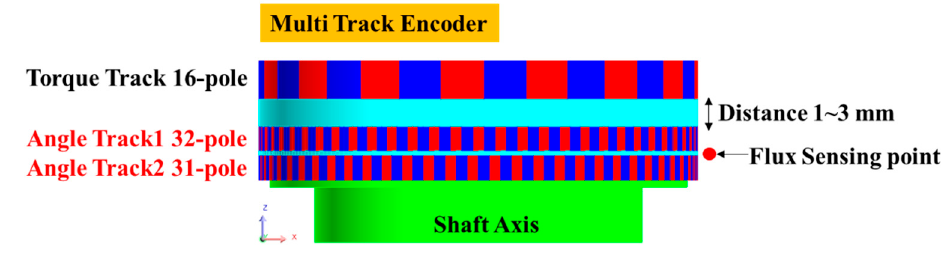
Figure 2. MTE design for finite element analysis.